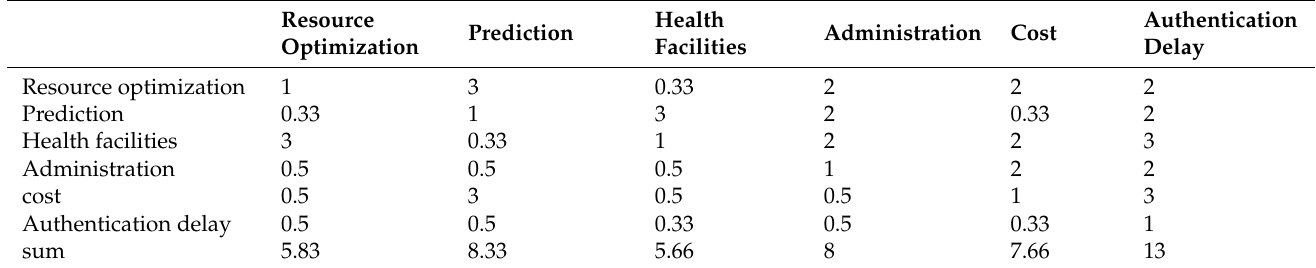
Table 3. Pair-Wise Comparison Matrix.